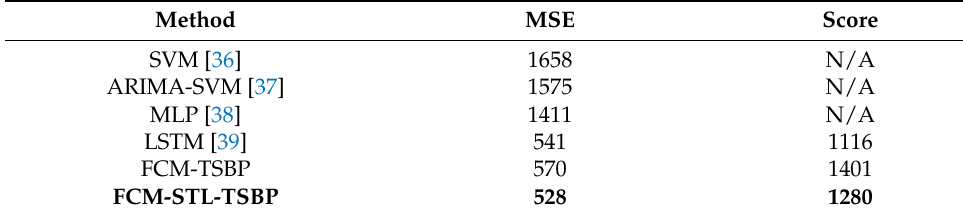
Table 5. Comparison test results.